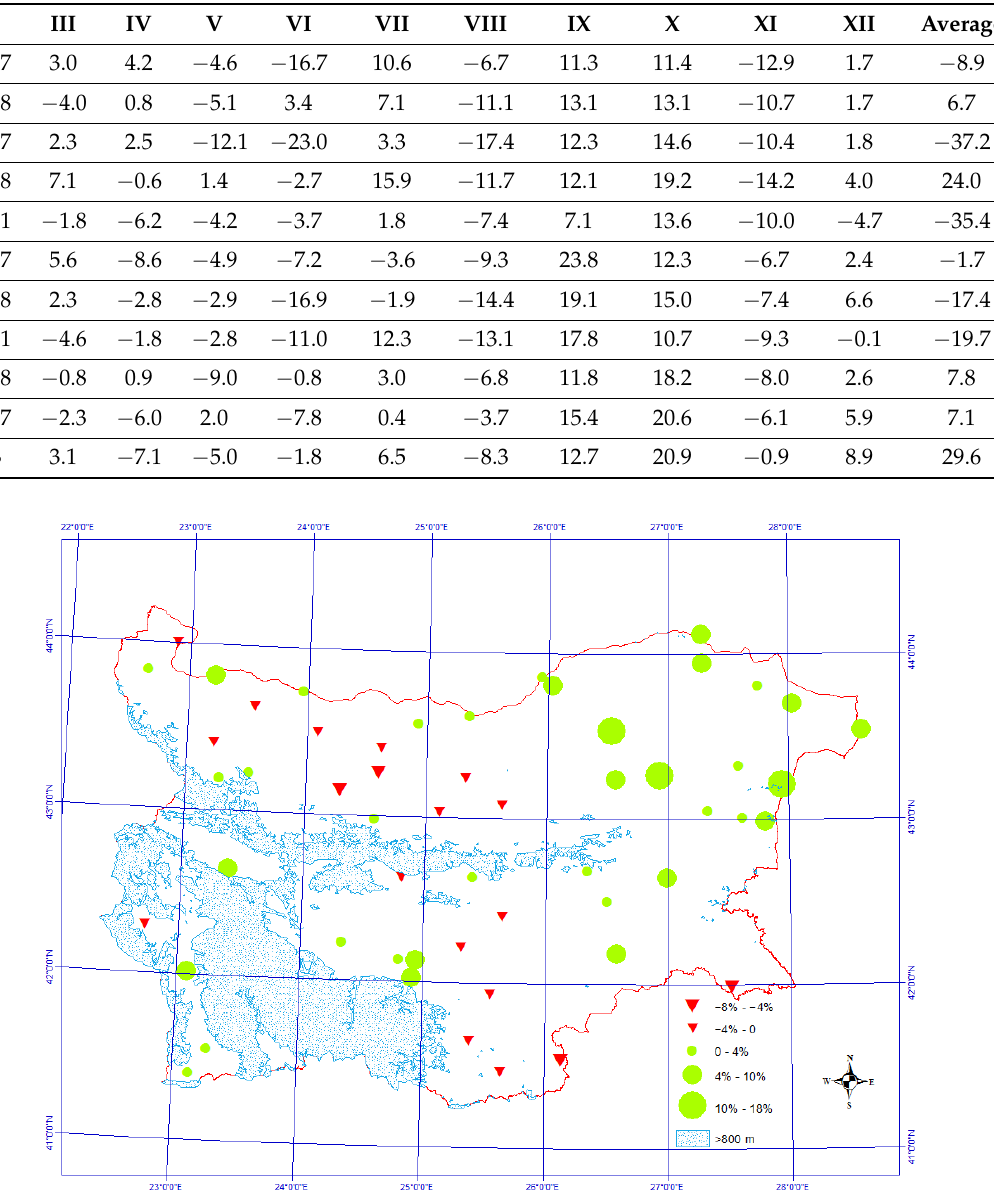
Figure 4. Deviations in yearly rainfall sums [mm]. Triangles shows decrease ( - ), and circles increase of rainfall